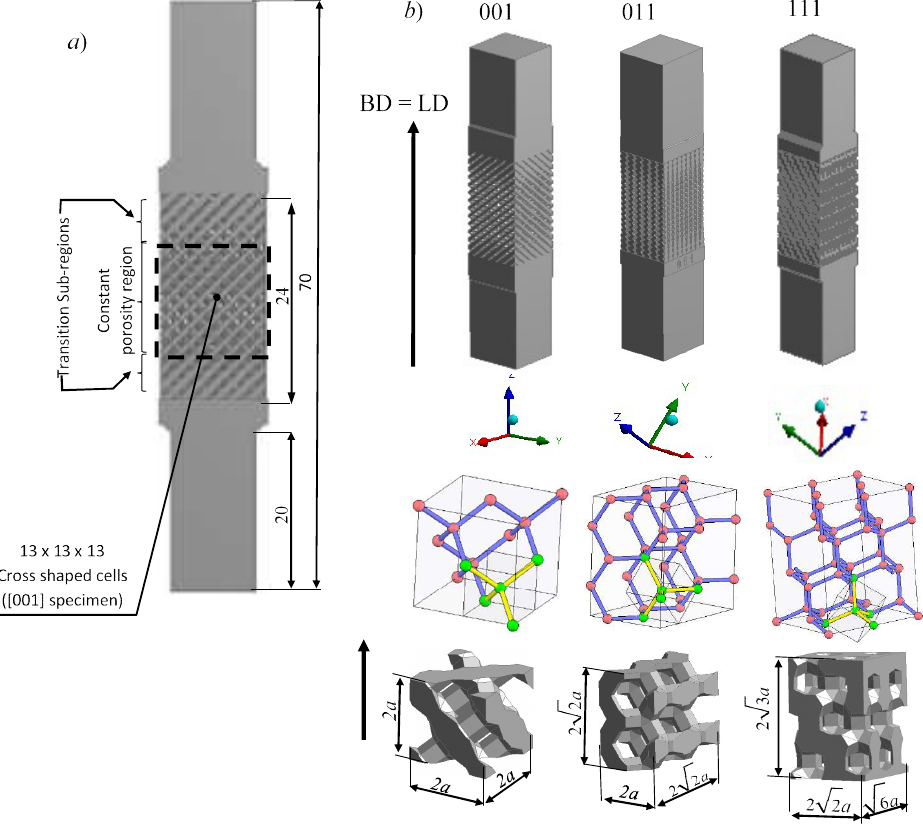
Figure 3. Tensile specimens of differently oriented diamond cell lattice structures: ( a ) principal dimensions and description of the different regions of [011]-oriented specimens (dimensions in mm); ( b ) CAD models and schematic representations of the periodic unit cells of this study.